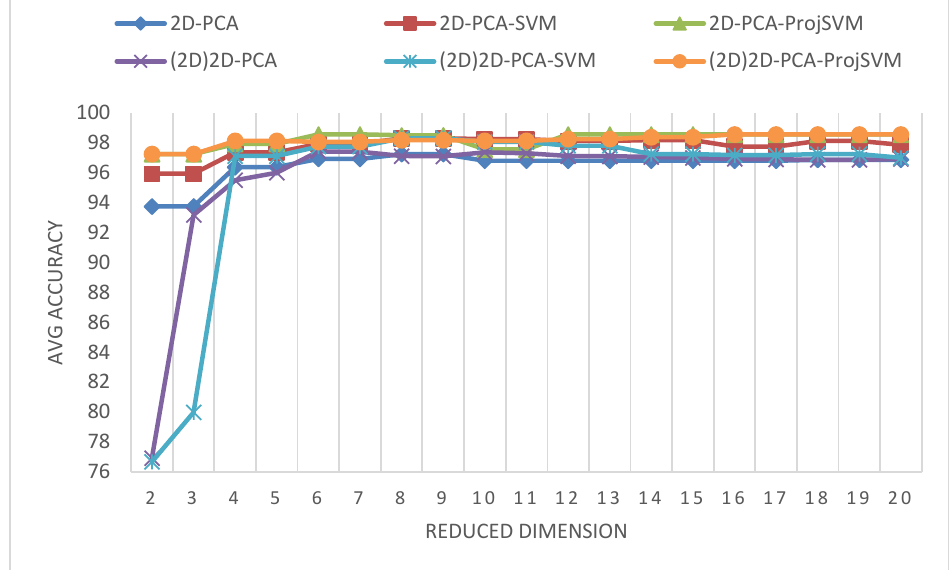
Figure 2. Average accuracy versus reduced dimension for six methods on JAFFE dataset with PCA-based